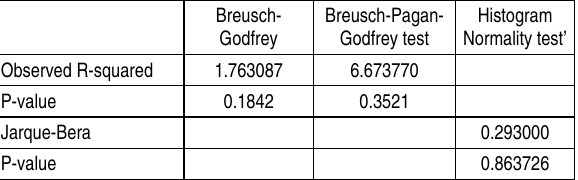
Table 5 . Summary of results of residual